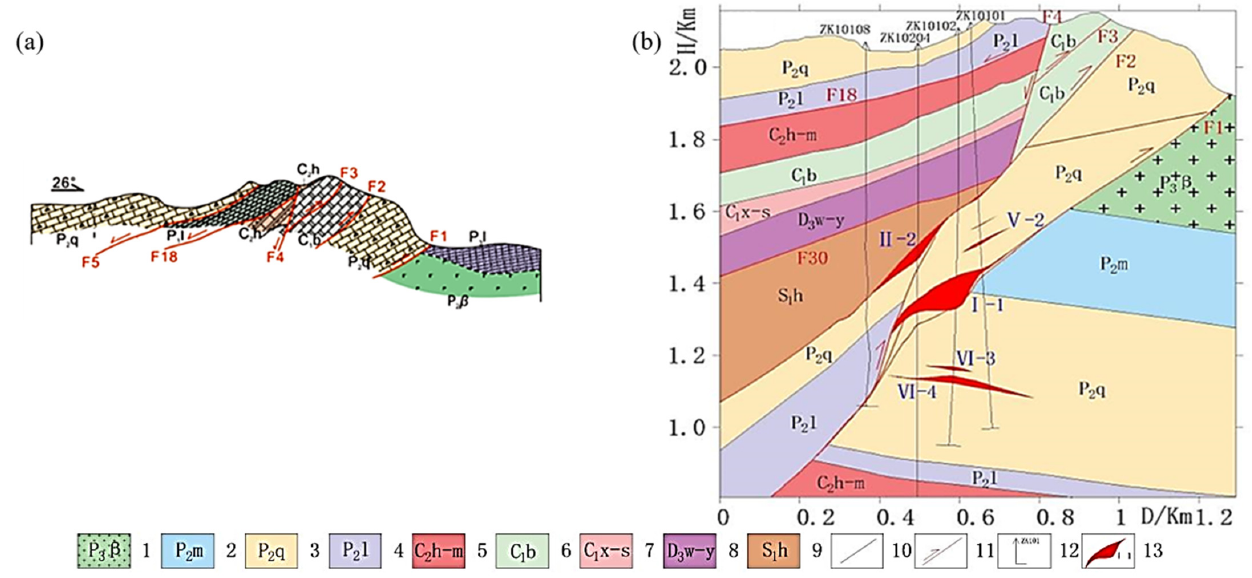
Figure 3. Geological cross ‐ section of the Zhugongtang deposit on the AMT survey line: ( a ) showing the thrust system (adopted from [35]), ( b ) stratigraphic boundary and boreholes (from after [35]). H: elevation, D: distance, 1: upper Permian Emeishan basalt formation; 2: middle Permian Maokou formation; 3: middle Permian Qixia formation; 4: middle Permian Liangshan formation; 5: upper